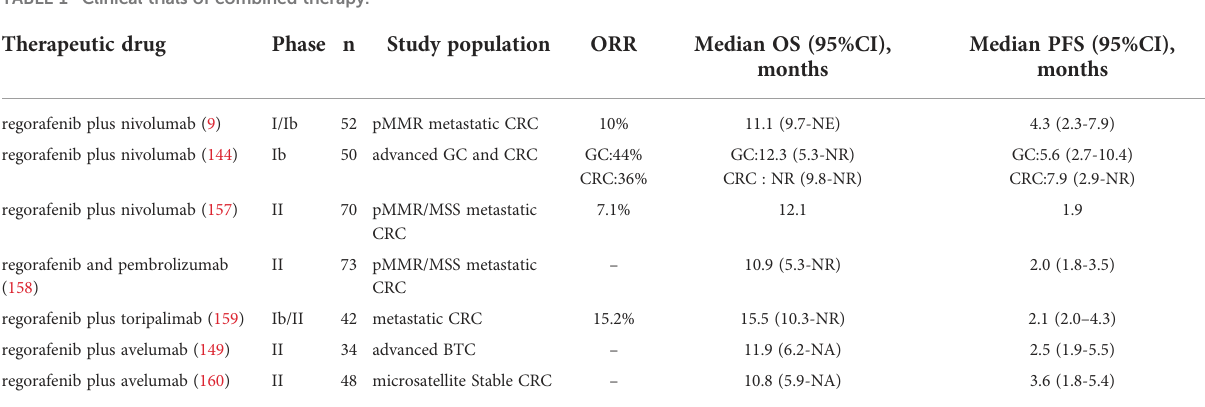
TABLE 1 Clinical trials of combined